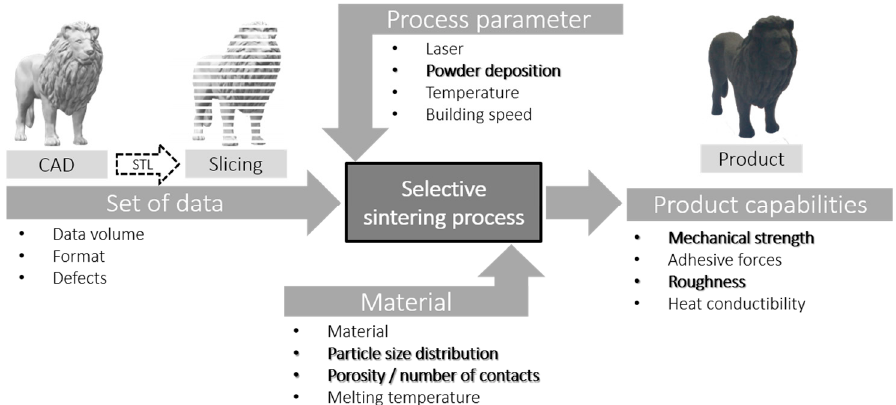
Figure 1. Influencing and in this paper analyzed variables and product properties in selective laser sintering